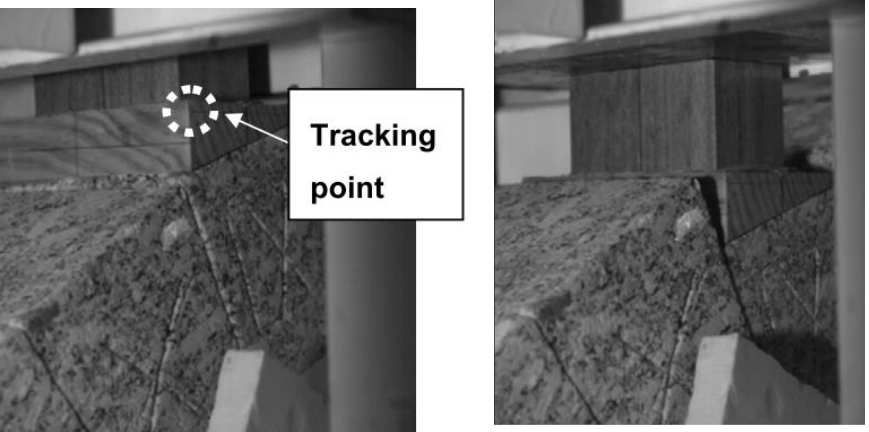
Table 3. Maximum vertical responses obtained at quarter span during the experiments.